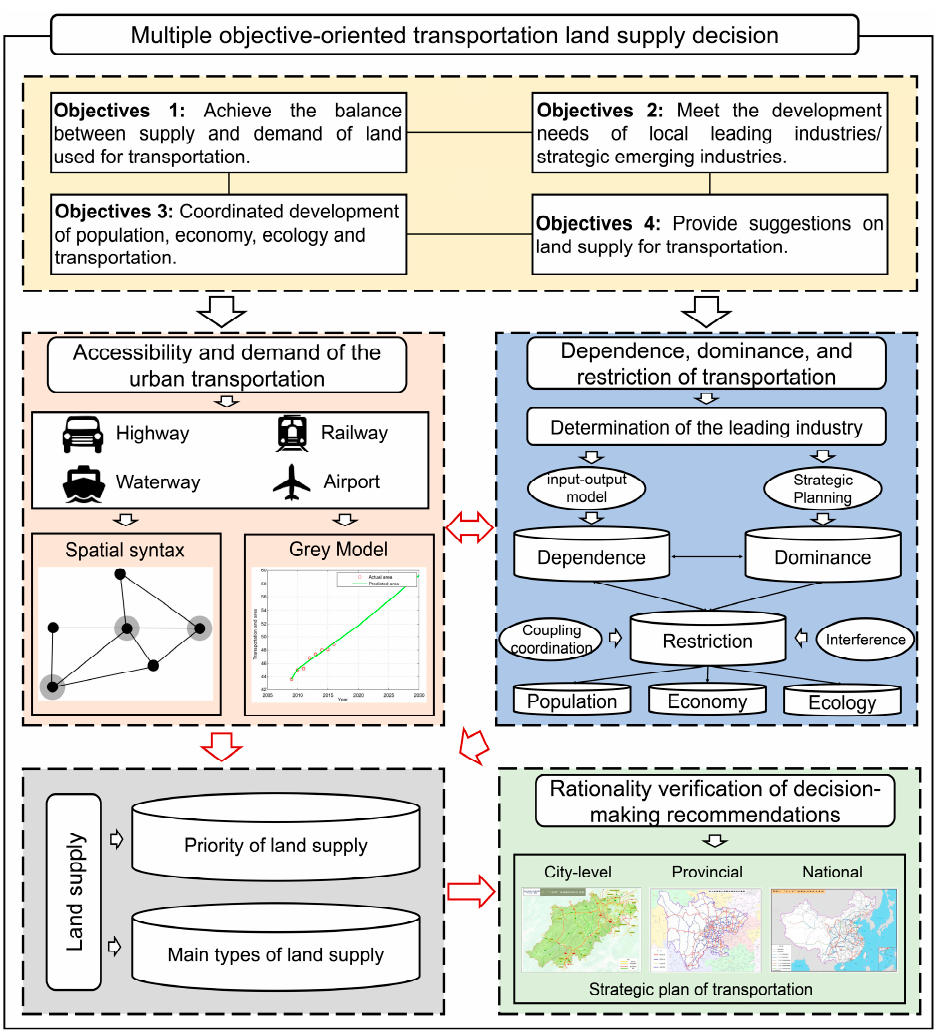
Figure 1. Decision support system of transportation land supply.